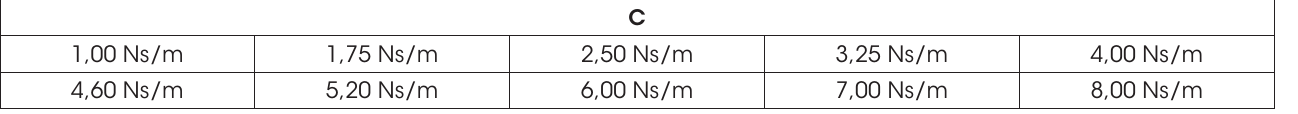
Damping coefficient of the standard dissipative elements